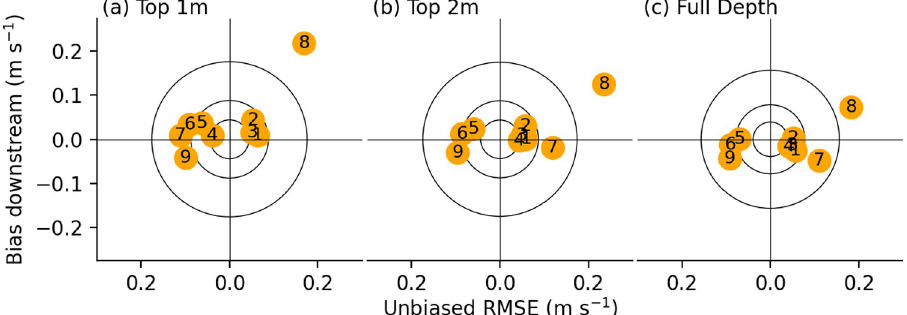
Fig 5. Hydrodynamic model calibration target diagrams. Target diagrams depicting model skill per transect for the three vertical averaging ranges. Transects are numbered 1 (most upstream) to 7 (junction), 8 (Old River), and 9 (San Joaquin River, downstream of junction). Points nearer the center have less error, with a vertical offset from the center denoting bias (i.e. systematic error), and a horizontal offset from center denoting unbiased root mean square error (uRMSE, i.e. random error). Predicted variance dictates whether points fall left of center (underpredicted variance) or right of center (overpredicted variance). Circles show the scale of 0.25, 0.5, and 1.0 standard deviations (calculated across all transects). Transects 8 and 9 are shown but correspond to portions of the domain that were not used in the analysis.